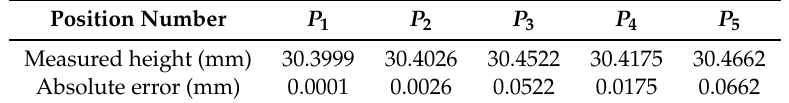
Table 1. Experimental results of measuring the measurement accuracy of the 3D vision system.